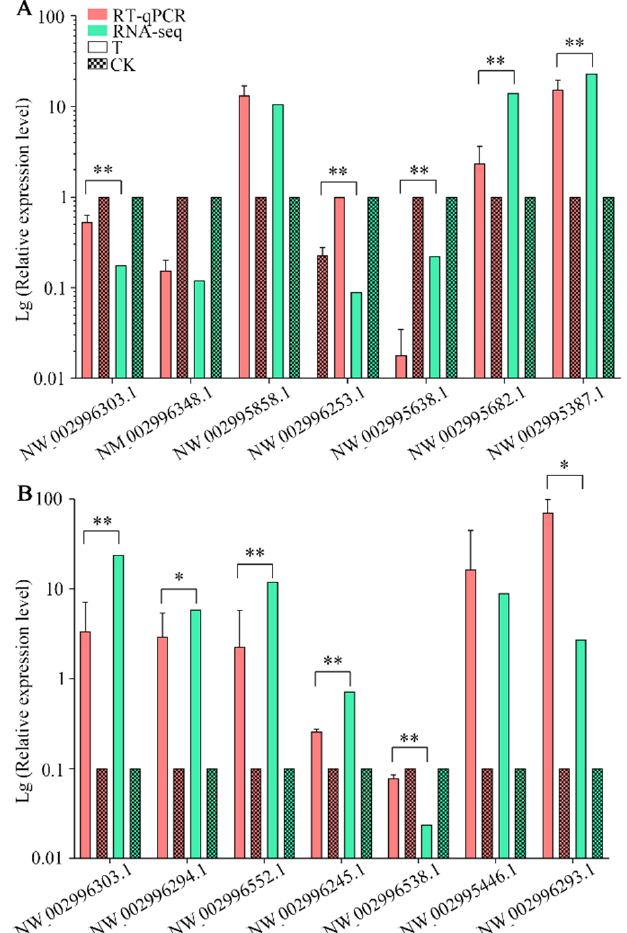
Figure 7. RT-qPCR verification of DEGs in N. ceranae infecting A. c. cerana workers. ( A ) DEGs in NcCK vs. NcT1. ( B ) DEGs in NcCK vs. NcT2. Error bars represent the variance of RT-qPCR results of each DEG. Bars with asterisk symbol indicate statistical differences ( p < 0.05).